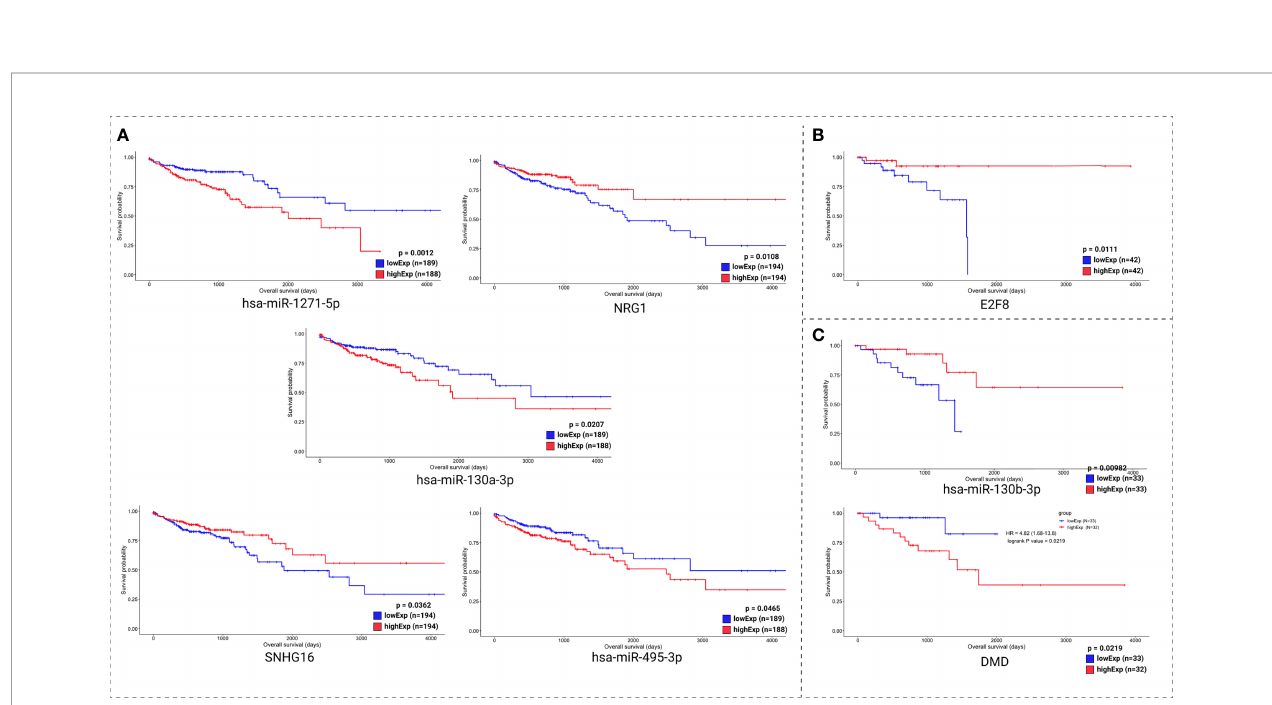
FIGURE 7 | Kaplan-Meier survival curves for the two best scored molecules for colon (A) , rectum (B) , and rectosigmoid junction (C) sites. Horizontal axis: overall survival time (in days). Vertical axis: survival probability.